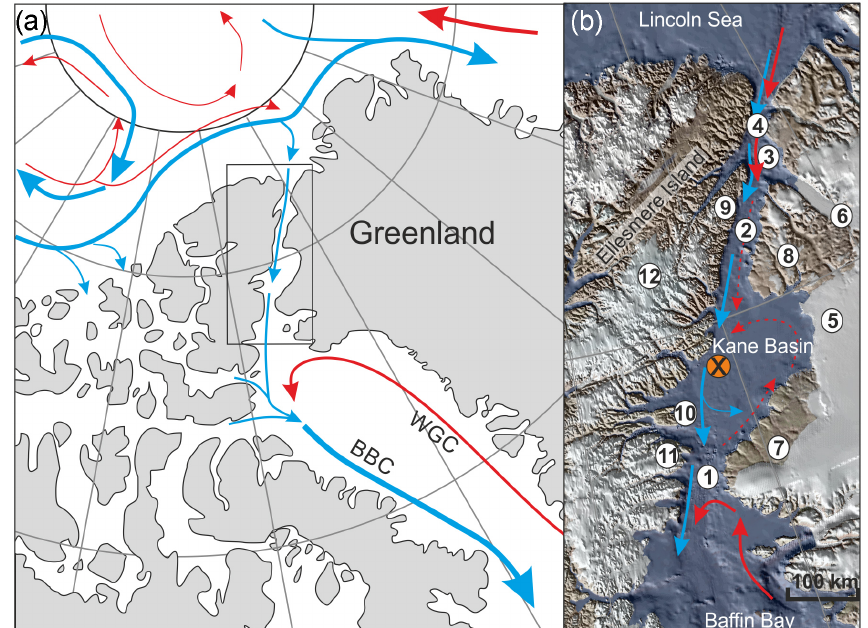
Figure 1. Schematic circulation in the Canadian and northern Greenland sectors of the Arctic Ocean (a) and within Nares Strait (b) . The location of core AMD14-Kane2b is marked by a cross. Blue arrows represent Arctic water and red arrows predominantly Atlantic water. WGC: West Greenland Current, BBC: Baffin Bay Current. 1 – Smith Sound; 2 – Kennedy Channel; 3 – Hall Basin; 4 – Robeson Channel, 5 – Humboldt Glacier; 6 – Petermann Glacier; 7 – Inglefield Land; 8 – Washington Land; 9 – Judge Daly Promontory; 10 – Bache Peninsula; 11 – Johan Peninsula; 12 – Agassiz Ice